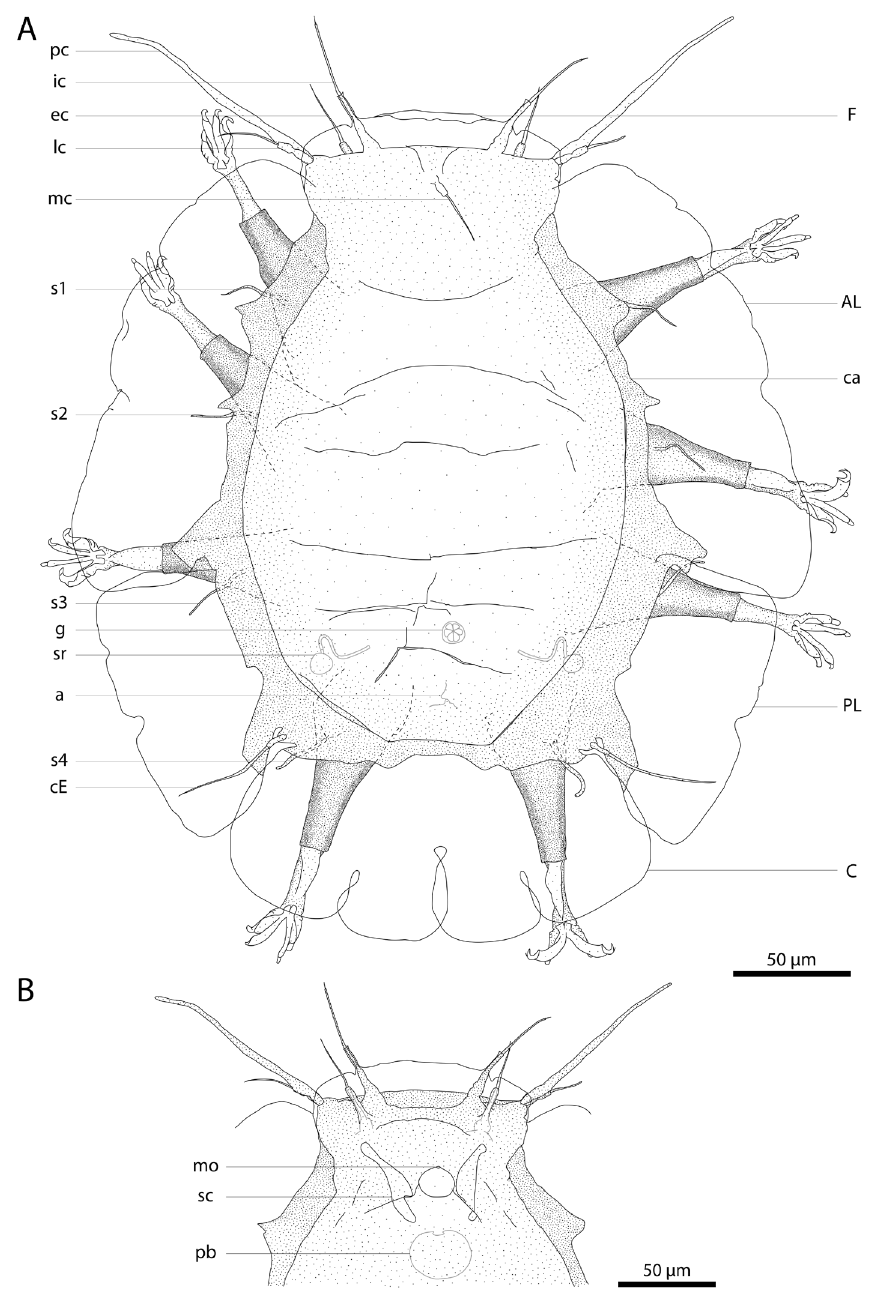
Figure 2. Drawing of Florarctus wunai sp. n., holotype KUZ Z705. A dorsal view B ventral view of ce- phalic region. a anus; AL anterolateral ala; C caudal ala; ca caestus; cE cirrus E; ec external cirrus; F frontal ala; g gonopore; ic internal cirrus; lc lateral cirrus; mc median cirrus; mo mouth; pb pharyngeal bulb; pc primary clava; PL postero-lateral ala; sc secondary clava; sr seminal receptacle; s1–4 leg I–IV sense